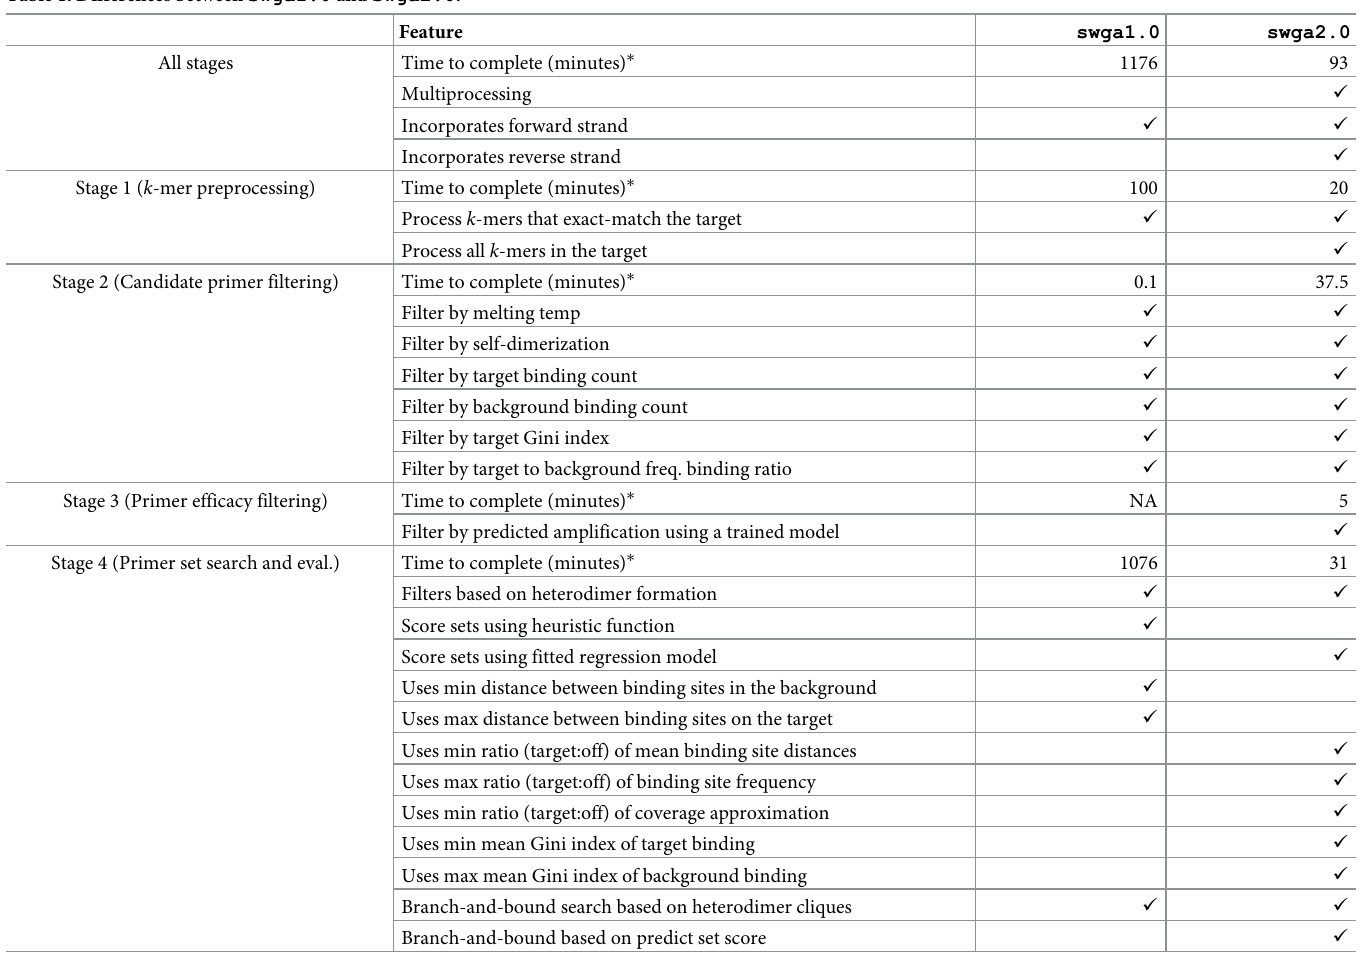
Table 1. Differences between swga1.0 and swga2.0